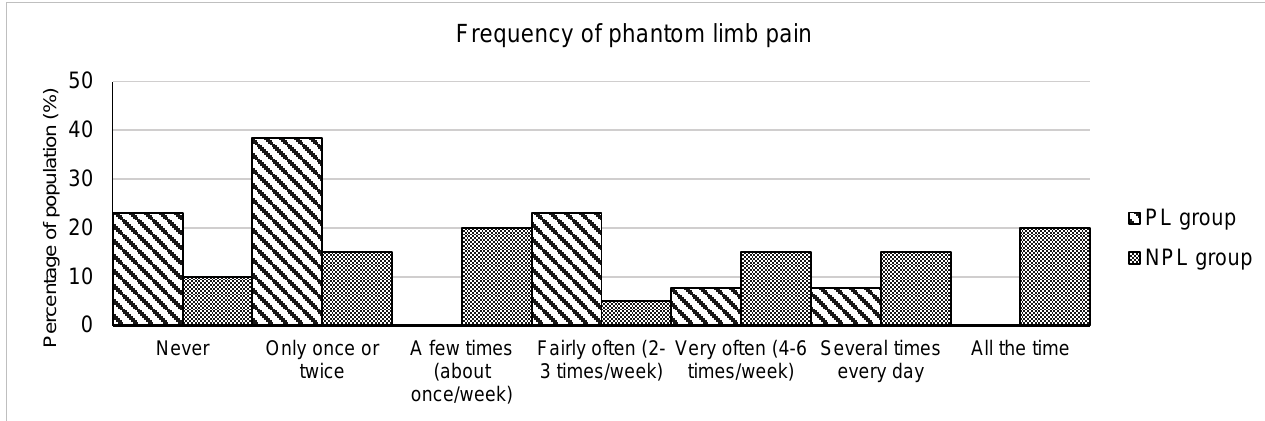
Figure 3: PEQ pain subset results for the frequency of the residual limb pain experienced by both PL (striped) and NPL (grey) groups. A skew to the left indicates less pain. The difference between the group was significant (p<0.05) with PL users experiencing less pain .